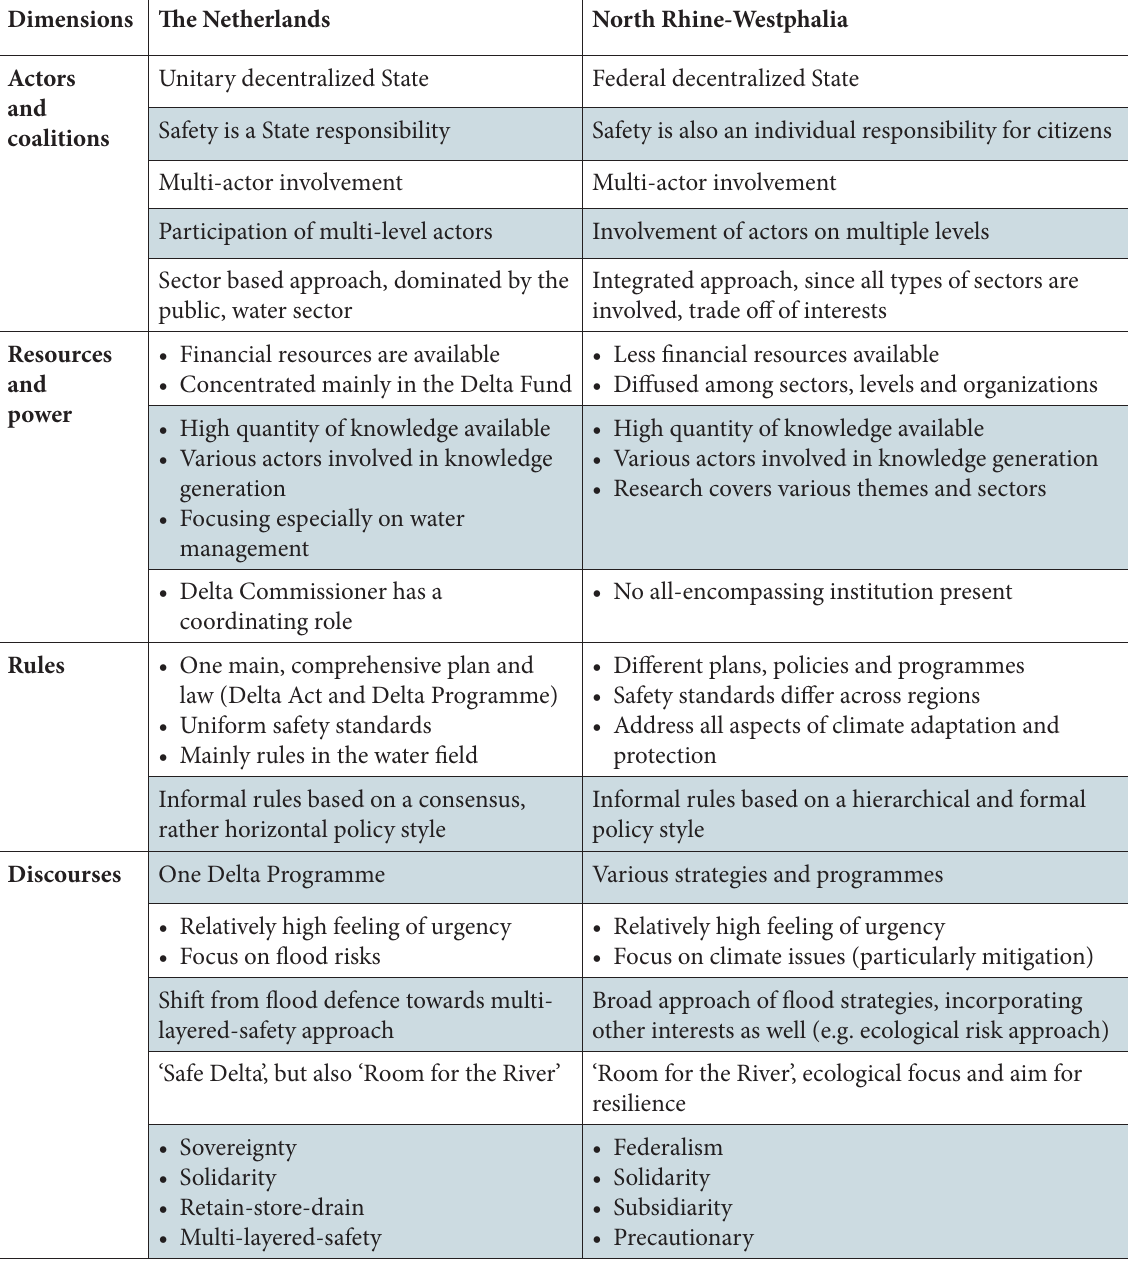
Table 1 A comparison of the North Rhine-Westphalian and Dutch policy arrangements on climate adaptation Dimensions The